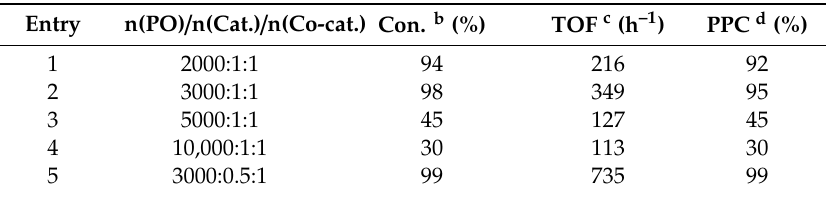
Table 6. (Salen- 4 )[Co(III)TFA] 2 / [PPN]TFA catalyzed PO / CO 2 copolymerization at different substrate concentrations a